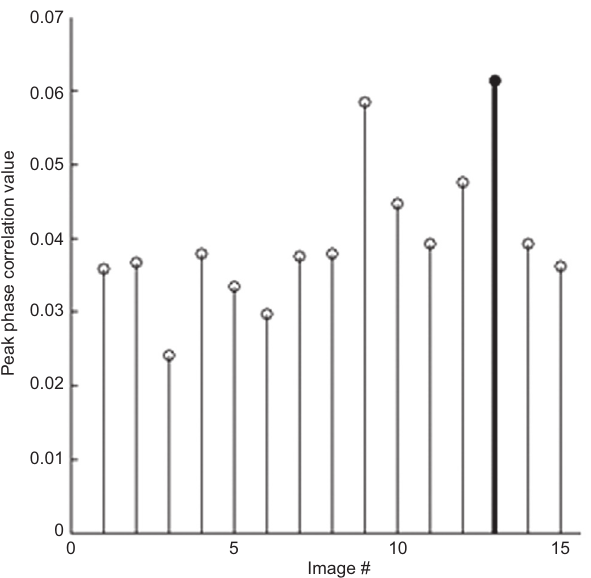
Figure 26. Comparison of Peak Phase Correlation Values for Test Image2 and Different Data- base